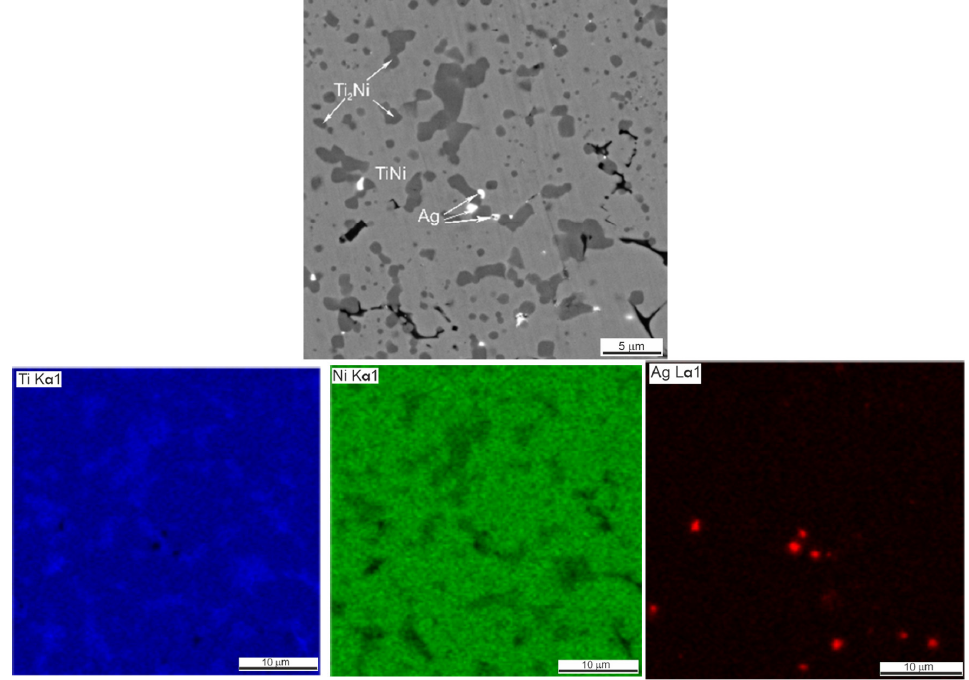
Figure 5. SEM image and EDS elemental mapping of porous SHS TiNi + 0.2% Ag.